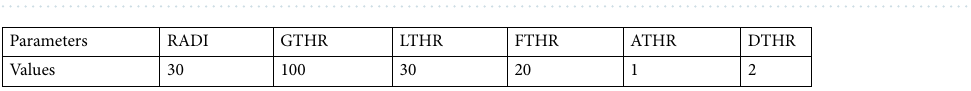
Table 1. The used parameters for the automatic extraction of lineaments from the SRTM data of the study area. RADI filter radius, GTHR edge gradient threshold, LTHR curve length threshold, FTHR line fitting error threshold, ATHR angular difference threshold, DTHR linking distance